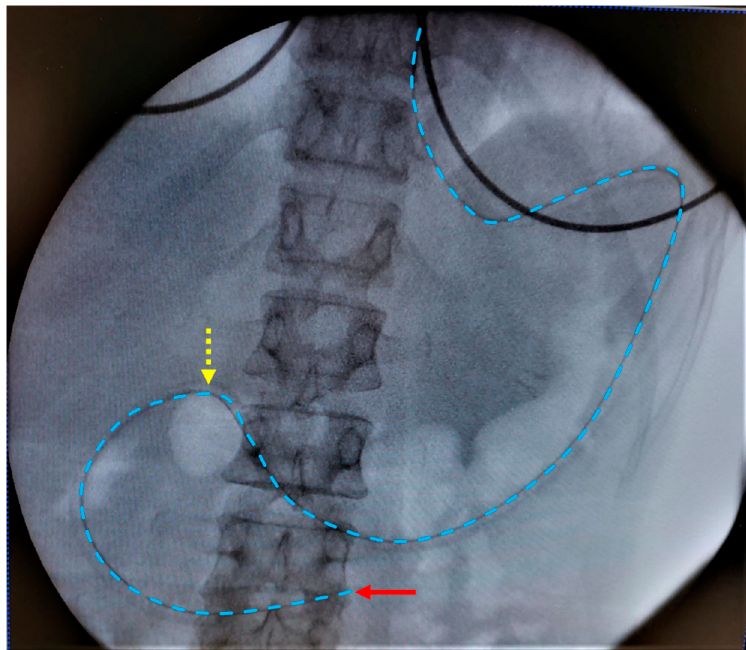
Figure 2. Typical fluoroscopy image with placement of the aspiration tip (red arrow) of the duodenal catheter near the ligament of Treitz. The catheter is indicated by the blue dotted line. The yellow dotted arrow indicates the transition from stomach to duodenum.